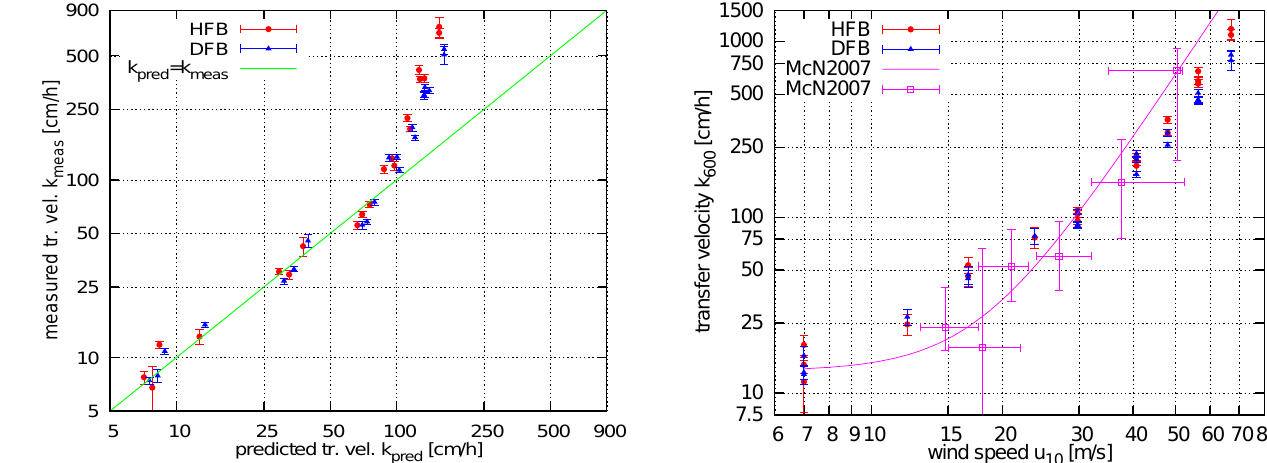
Fig. 5. Measured transfer velocities for HFB and DFB, compared to the data and parameterization by McNeil and D’Asaro (2007), all scaled to a Schmidt number of 600, in a double logarithmic